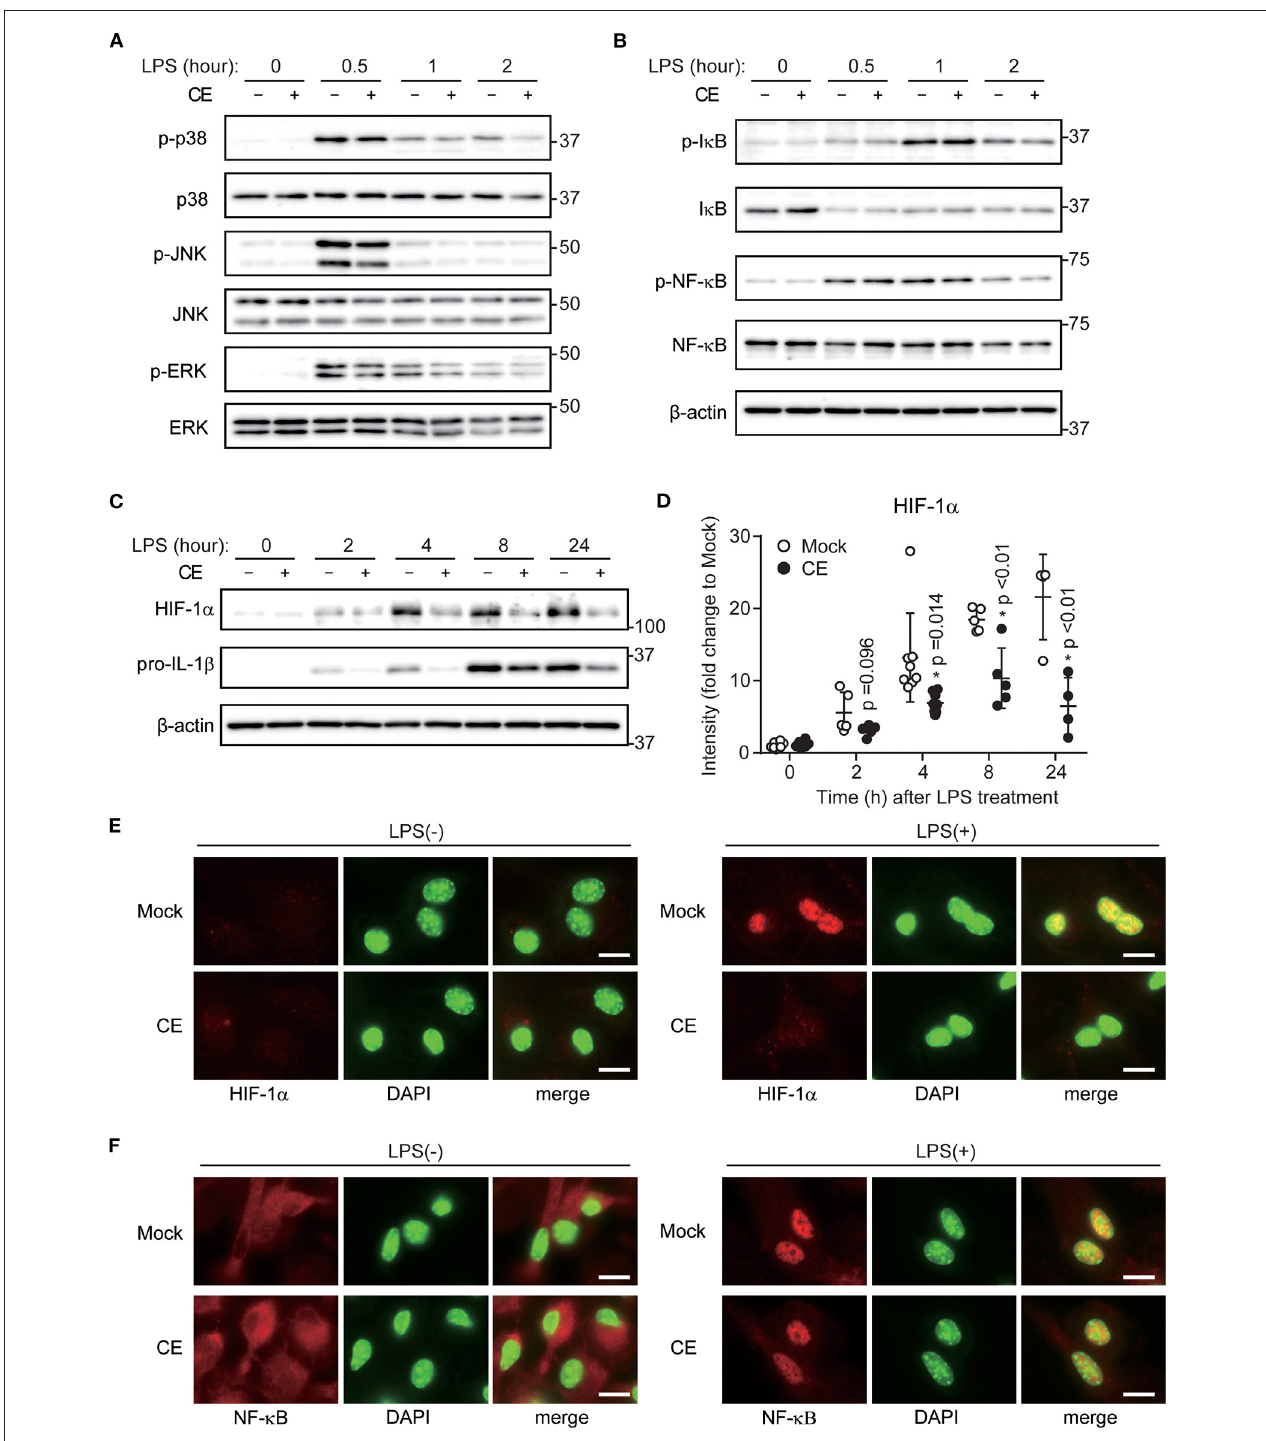
FIGURE 3 | Chlorella extract inhibits LPS-induced HIF-1 α activation. (A–D) BMDMs were treated with Mock or CE for 16h before being stimulated with 10ng/mL LPS for the indicated time periods. Whole cells lysates were analyzed by western blotting for total and phosphorylation of p38, JNK, ERK (A) , I κ B, NF- κ B (B) , HIF-1 α and pro-IL-1 β . Quantification of HIF-1 α and pro-IL-1 β (D) was normalized to β -actin expression and relative to Mock only treated group. (E,F) Subcellular localizations of HIF-1 α (E) and NF- κ B (F) were performed by immunohistochemistry. DAPI was used to stain nuclei. Scale bar, 10 µ m. Error bar show mean ± SEM. * p < 0.05 vs. Mock-treated groups. Data are representative of at least three independent